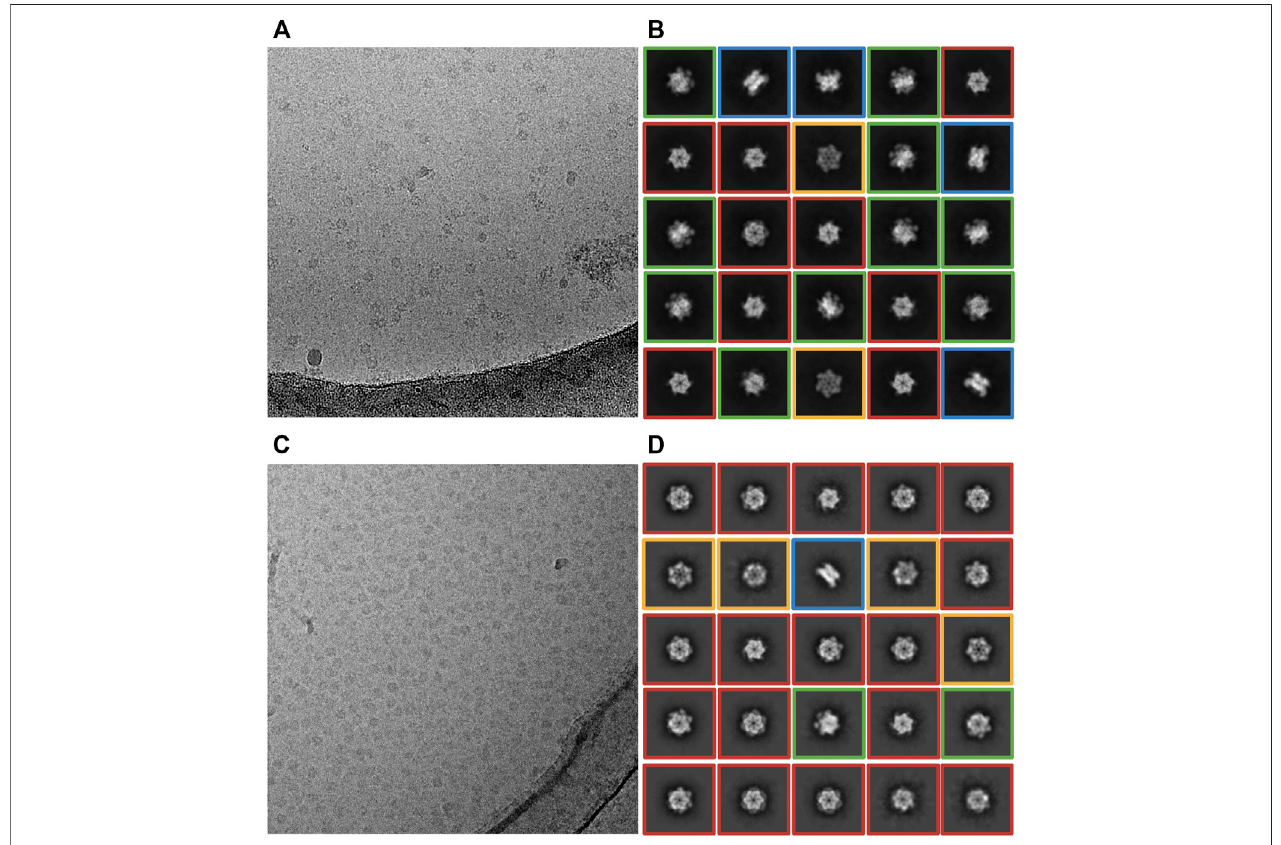
FIGURE 2 | Effect of ice thickness on the distribution of particle orientations. (A,B) Cryo-EM data collected at ACSMB from thick ice; grids were prepared using a Vitrobot. (A) Representative cryo-EM micrograph. (B) Representative 2D class averages. Various particle orientations are noted by red boxes (top view), orange boxes (bottom view), green boxes (intermediate view) or blue boxes (bottom view). (C,D) Cryo-EM data collected at eBIC from optimally thin ice; Blot-free grids were prepared using the Chameleon instrument. (C) Representative cryo-EM images. (D) Representative 2D class averages. Various particle orientations are noted by red boxes (top view), orange boxes (bottom view), green boxes (intermediate view) or blue boxes (bottom